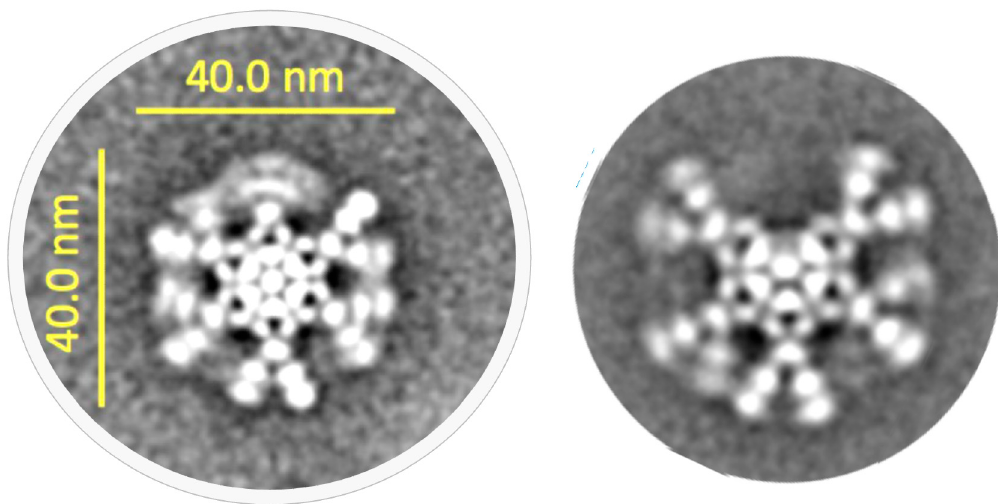
Figure 6. Example cryo-electron microscopy (cryo-EM) results for hexamer ( left ) and pentamer ( right ) forms of an anti-CD20 IgM. Consistent with published observations [91], the pentamer formed in the absence of J-chain retains the positions of monomers around the central ring and only a single monomer appears substituted by the J-chain. These images are a montage of a large series of negatively stained, transmission electron micrographs obtained via collaboration of IGM Biosciences and NanoImaging, Inc., San Diego, CA, USA (unpublished results).